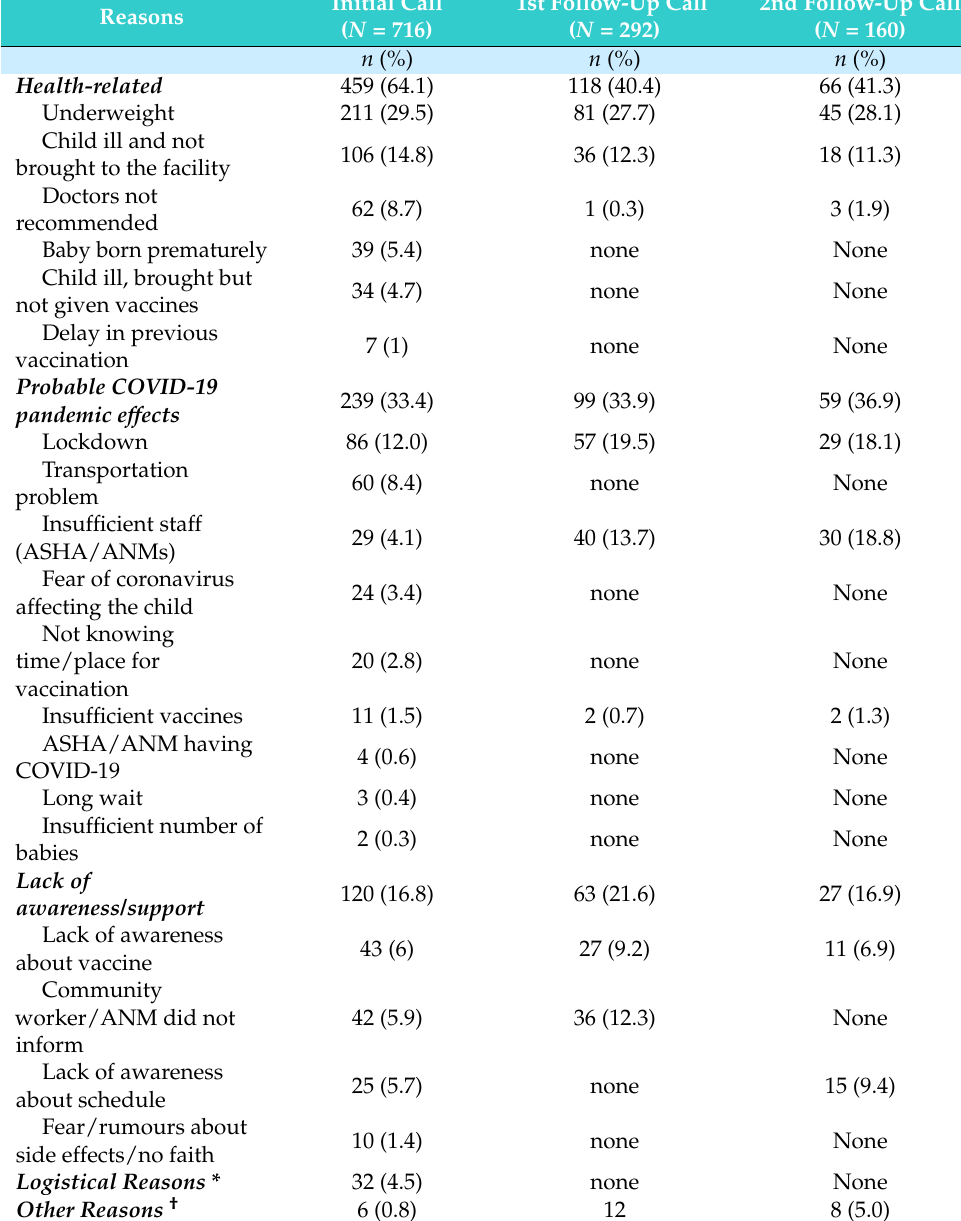
Table 3. Detailed reasons for non-vaccination during each